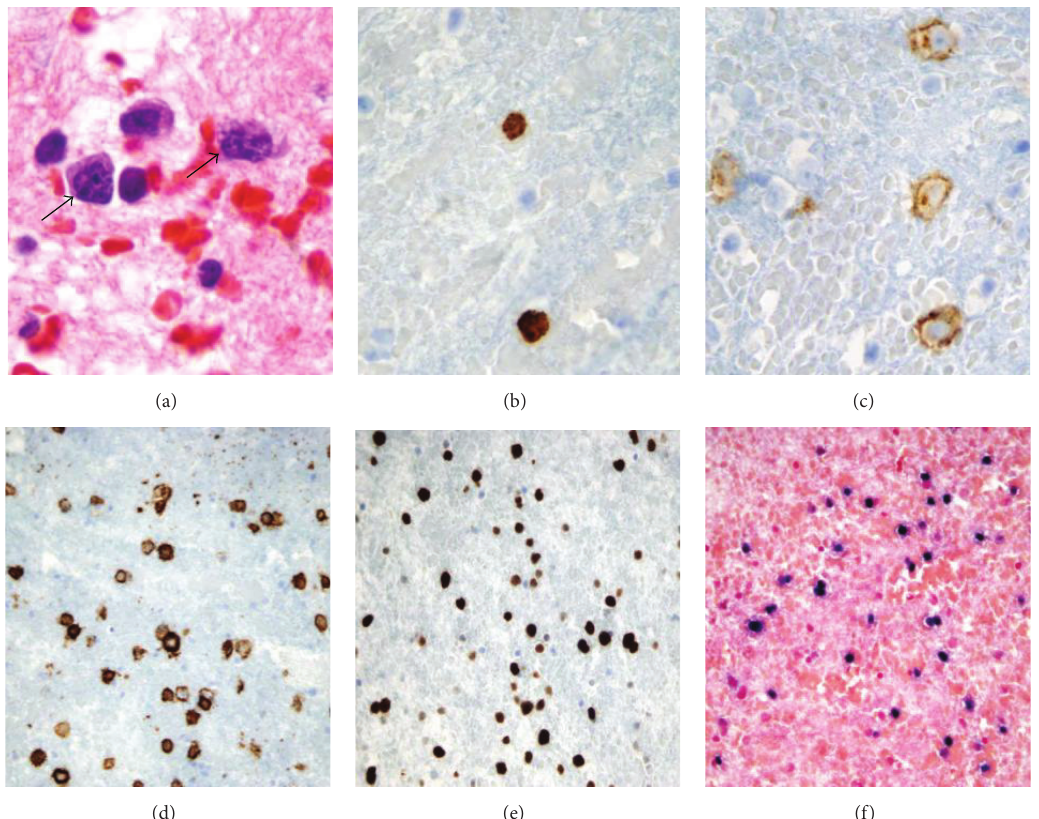
Figure 2: Cytologic evaluation of the pleural fluid shows large atypical lymphoid cells (arrows) ((a) H&E, × 100) expressing HHV8, CD30, and CD138 ((b), (c), and (d), resp.). The atypical cells show high proliferation index highlighted by Ki-67 immunostain (e) and positive staining for Epstein-Barr Virus (EBV) by in situ hybridization